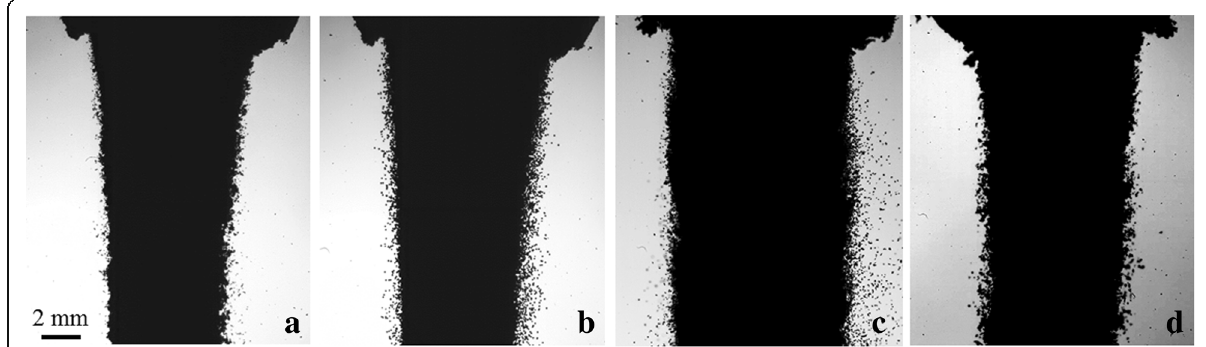
Fig. 8 Granular streams at the funnel aperture in air. a 50 μ m glass beads, b 100 μ m glass beads, c 77 μ m alumina particles, and d 73 μ m